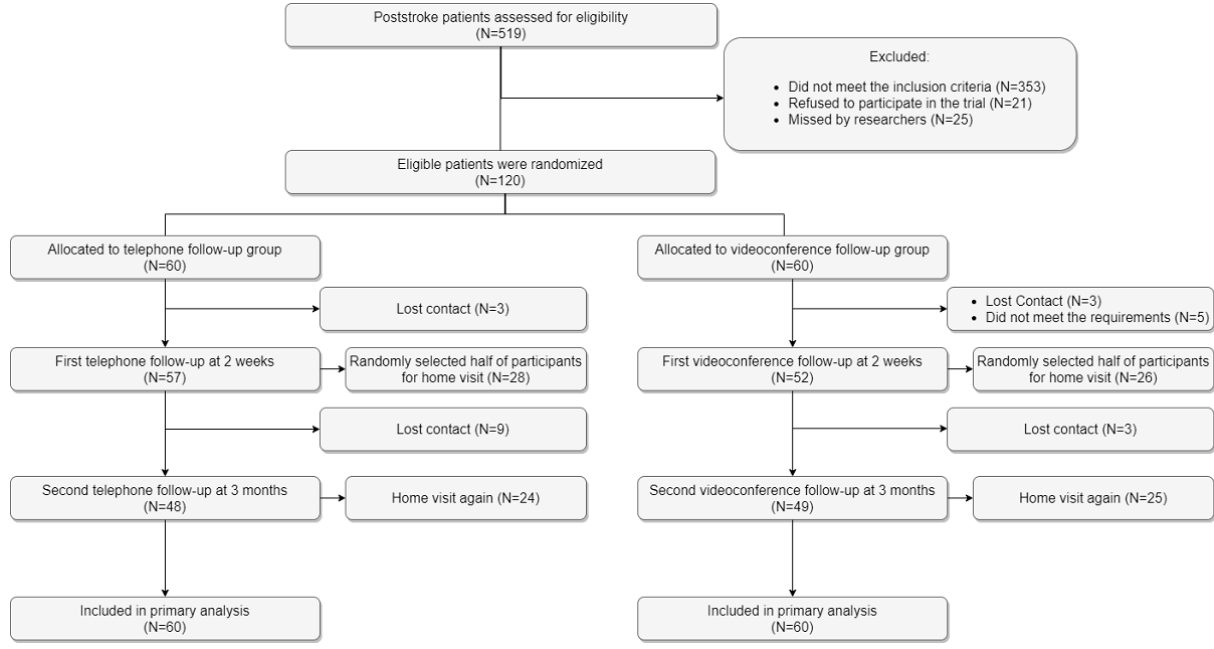
Figure 1. A flow diagram of patient